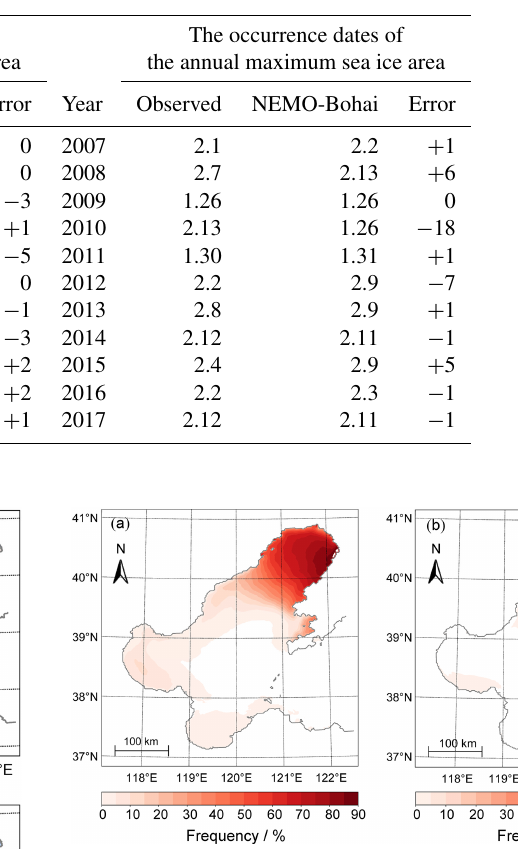
Figure 18. Frequency distribution of daily sea ice thickness larger than 10cm (a) and 25cm (b) in the Bohai Sea during 1996–2017.